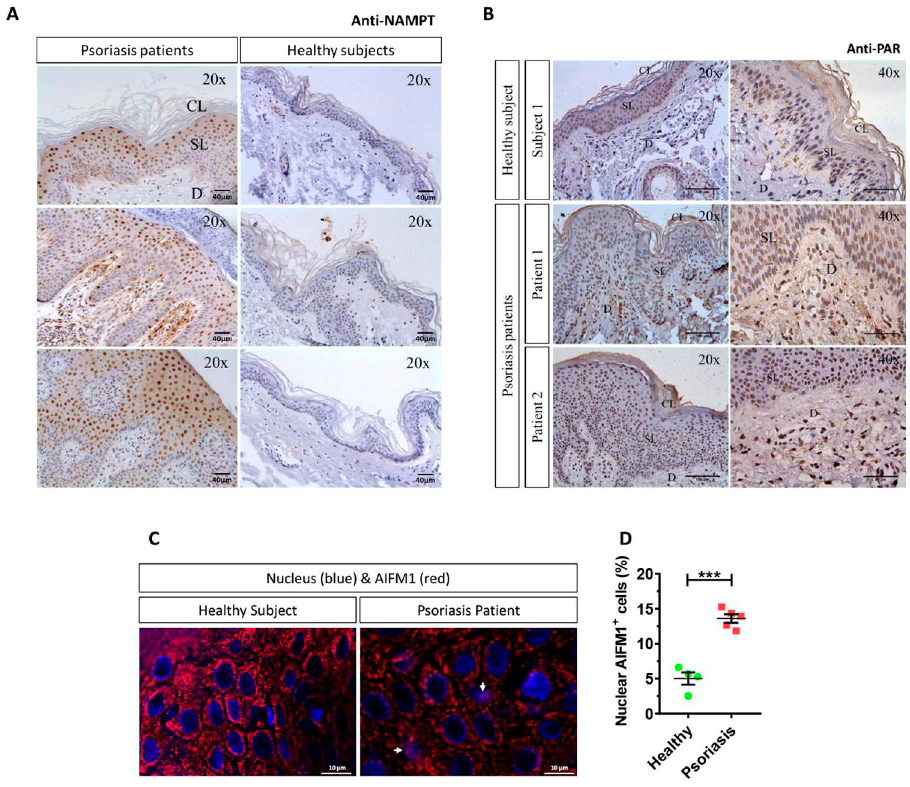
Fig 7. Robust increase of NAMPT protein amount, PARylation, and nuclear translocation of AIFM1 in lesional skin from psoriasis patients. (A–C) Representative images of sections from healthy and psoriatic skin biopsies that have been immunostained with an anti-NAMPT (A), anti-poly (ADP-ribose) (B), or anti-AIFM1 monoclonal antibodies and then slightly counterstained with hematoxilin (A, B) or DAPI (C). (D) The percentage of nuclear AIFM1 positive cells (white arrows) in human skin biopsies was calculated as the ratio between the number of keratinocytes in which AIFM1 is found in the nucleus and total keratinocyte number. Each point represents the mean of the quantification of 30 to 60 fields in section from an individual, and the mean ± SEM for each group is also shown. p -Values were calculated using t test. ��� p � 0.001. Scale bar is 40 μ m in A, 100 μ m and 50 μ m in left and right panels of B and 10 μ m in C. The data underlying this figure can be found in S1 Data. CL, cornified layer; D, dermis; Nampt, nicotinamide phosphoribosyltransferase; SL, spinous